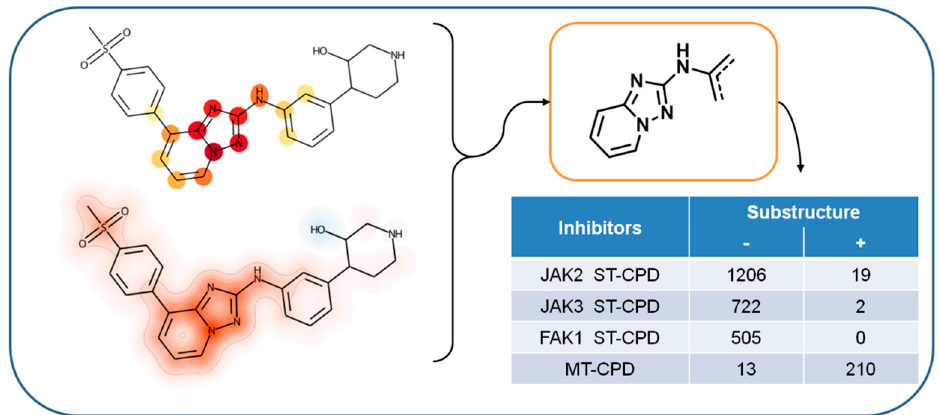
Figure 4. Feature mapping for MT-CPDs of triplet 1. Extracted features are mapped on exemplary correctly predicted MT-CPDs (upper left) on a per-atom basis. The continuous atom color code indicates the number of extracted features per atom, ranging from 1 (yellow) to 10 (dark red). In addition, SHAP values for all present features were mapped to the corresponding atoms and shown in a heat-map format (lower left). Both representations identify the [1,2,4]triazolo[1,5-a]pyridine substructure (upper right) as the center of positive feature contributions to the correct prediction of this MT-CPD and others containing this substructure. The presence (+) or absence ( − ) of the substructure in ST- and MT-CPDs of triplet 1 is reported in the table insert (lower right).